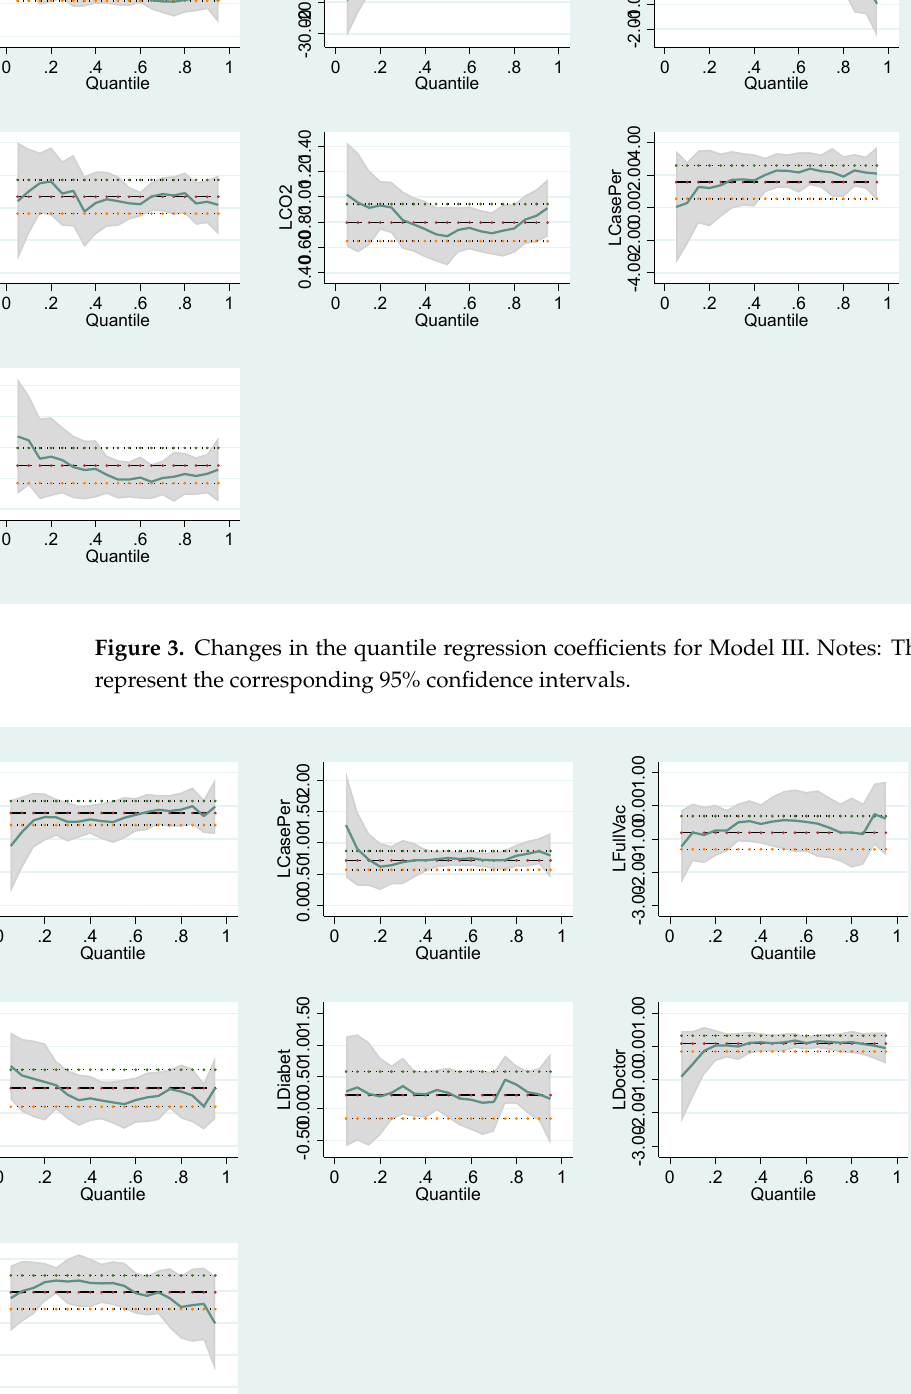
Figure 4. Changes in the quantile regression coefficients for Model IV. Notes: The shaded bands represent the corresponding 95% confidence intervals.